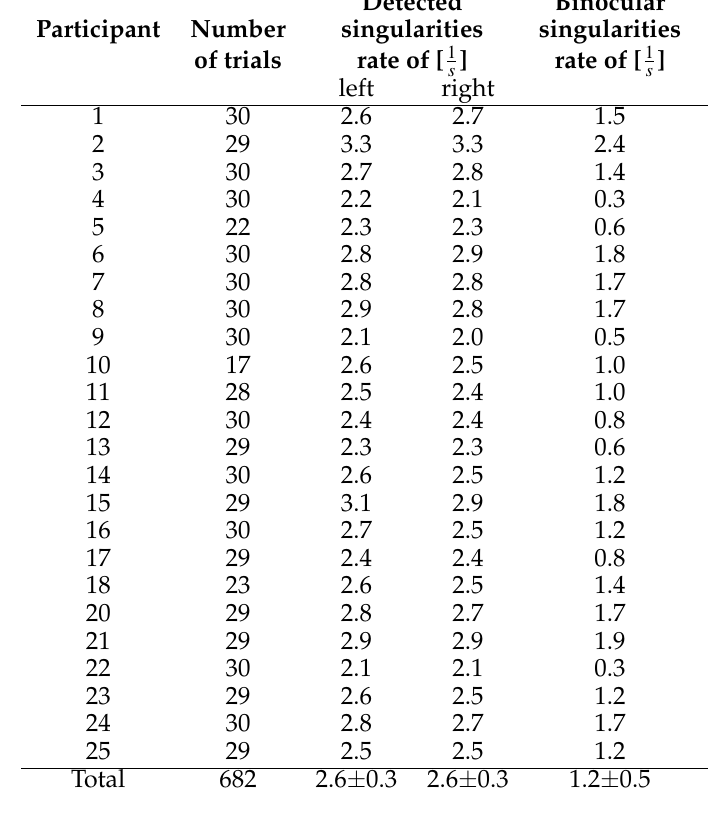
Rates of detected singularities in the horizonal eye movement in our fixation task experiment. The number of binocular singularities is a subset of all detected. The total rates are given as mean ± standard deviation. of both eyes) for 82.7 and 81.2% as well as 12.2 and 13.4% for pc 0 and pc 1 in left and right eye, respectively.